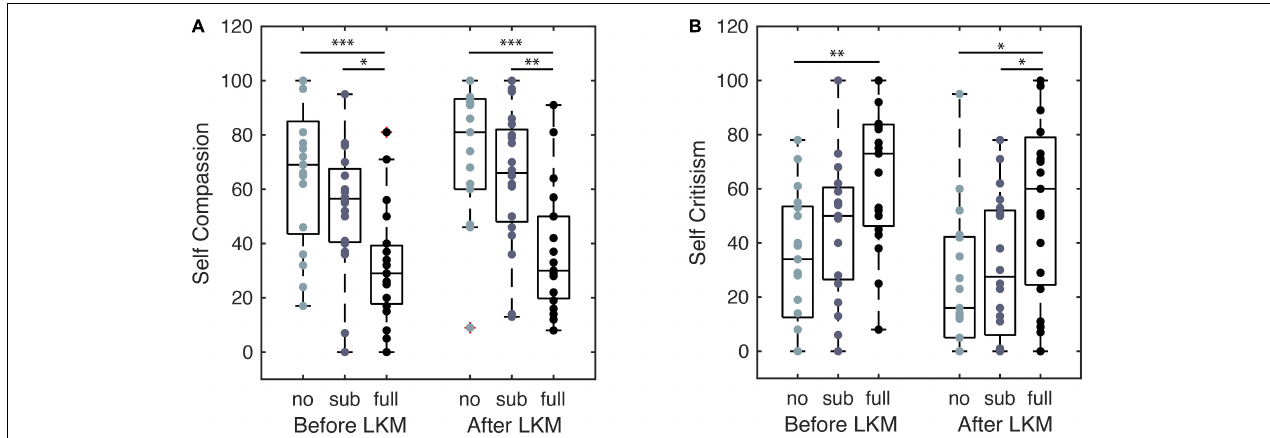
FIGURE 4 | Self compassion (A) and self-criticism (B) self-report scores from before and after the LKM-S. Each group, labeled no, sub, and full PTSD, are shown at each time point with significance levels ∗ p < 0.05, ∗∗ p < 0.01, ∗∗∗ p <